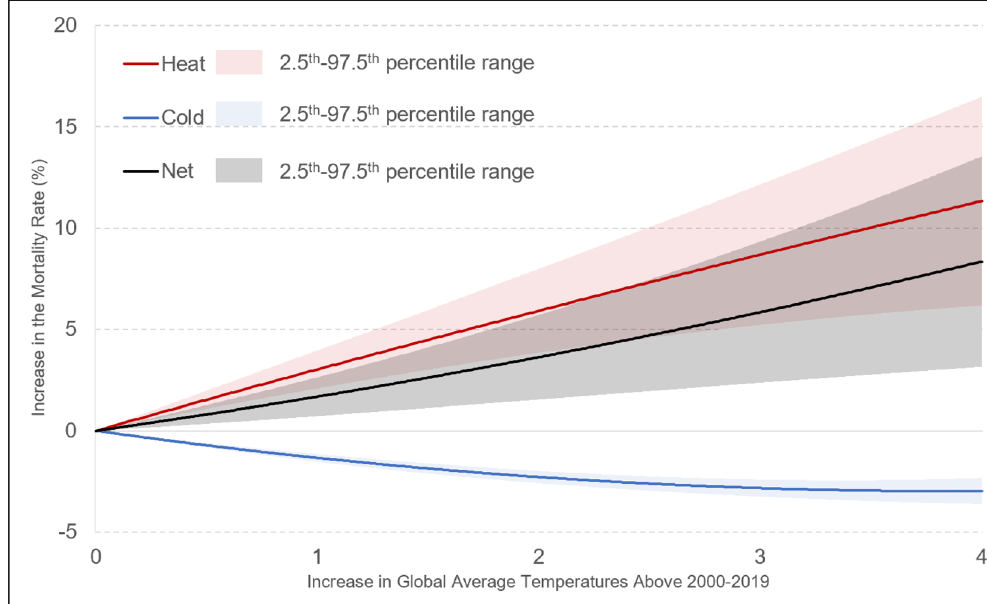
Figure 3. Increases in the global mortality rate as a function of the increase in global average temperature (without income-based adaptation). Under climate change, heat is expected to cause an increase in mortality (red line) while cold is expected to cause a decrease in mortality (blue line). The effect of heat is expected to outweigh the effect of cold, and the net result of these two effects is an increase in the mortality rate (black line). At 4 °C warming above the correct level, the mortality rate is expected to increase by 8.4% relative to a counterfactual scenario in which there is no warming and the contribution of temperature-related mortality towards the mortality rate remains constant at the present